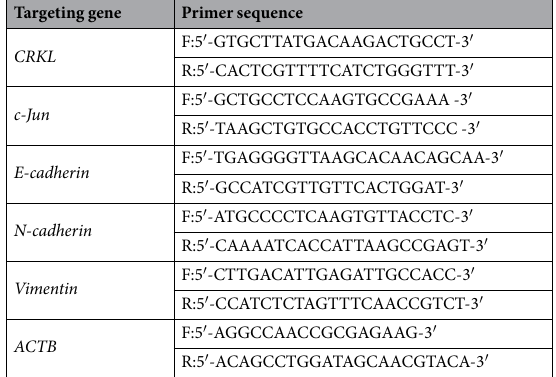
Table 1. Synthesized sequences of primers for targeting